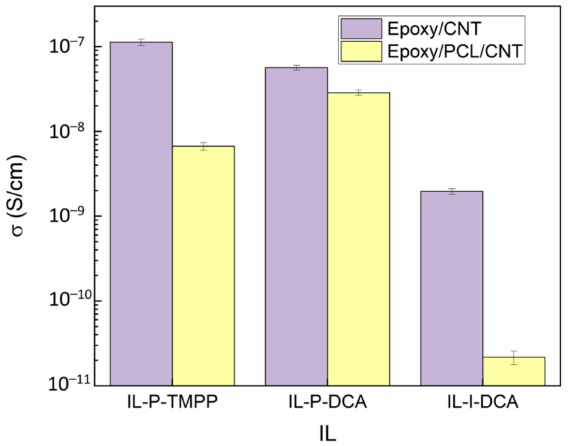
Figure 4. Electrical conductivity of the epoxy/PCL/CNT NCs and the reference epoxy/CNT NCs cured with the three different ILs.